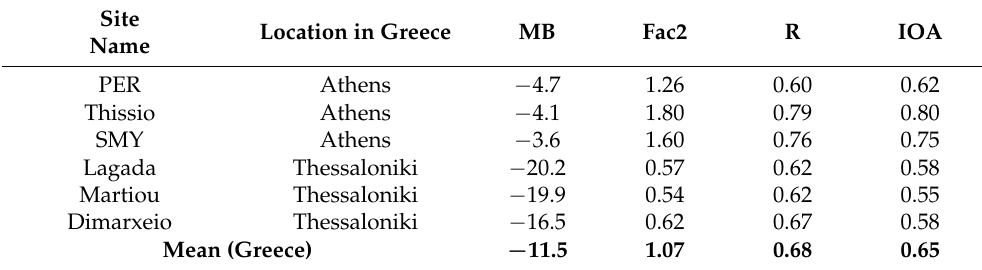
Table 5. Statistical metrics for NO mean daily concentrations ( µ g/m 3 ) for each monitoring site over Thessaloniki, Greece (for d03 domain, 2 × 2 km 2 ) and the rest of Greece (for d02 domain, 6 × 6 km 2 ) for the cold period of 2015 (January–April, October–December) for the on-line_SCN.